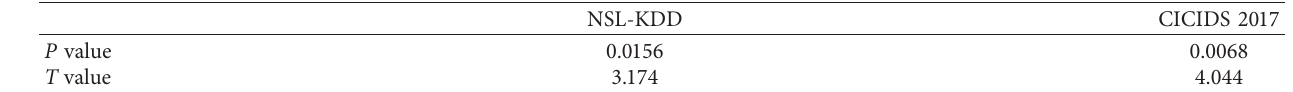
Table 13: T -test results.